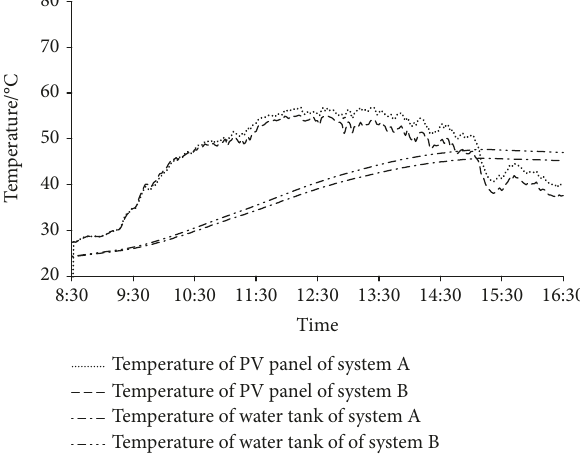
Figure 6: Viscosity of 30% alkyl hydrocarbon PCS before and after ten months ’ steady placement.